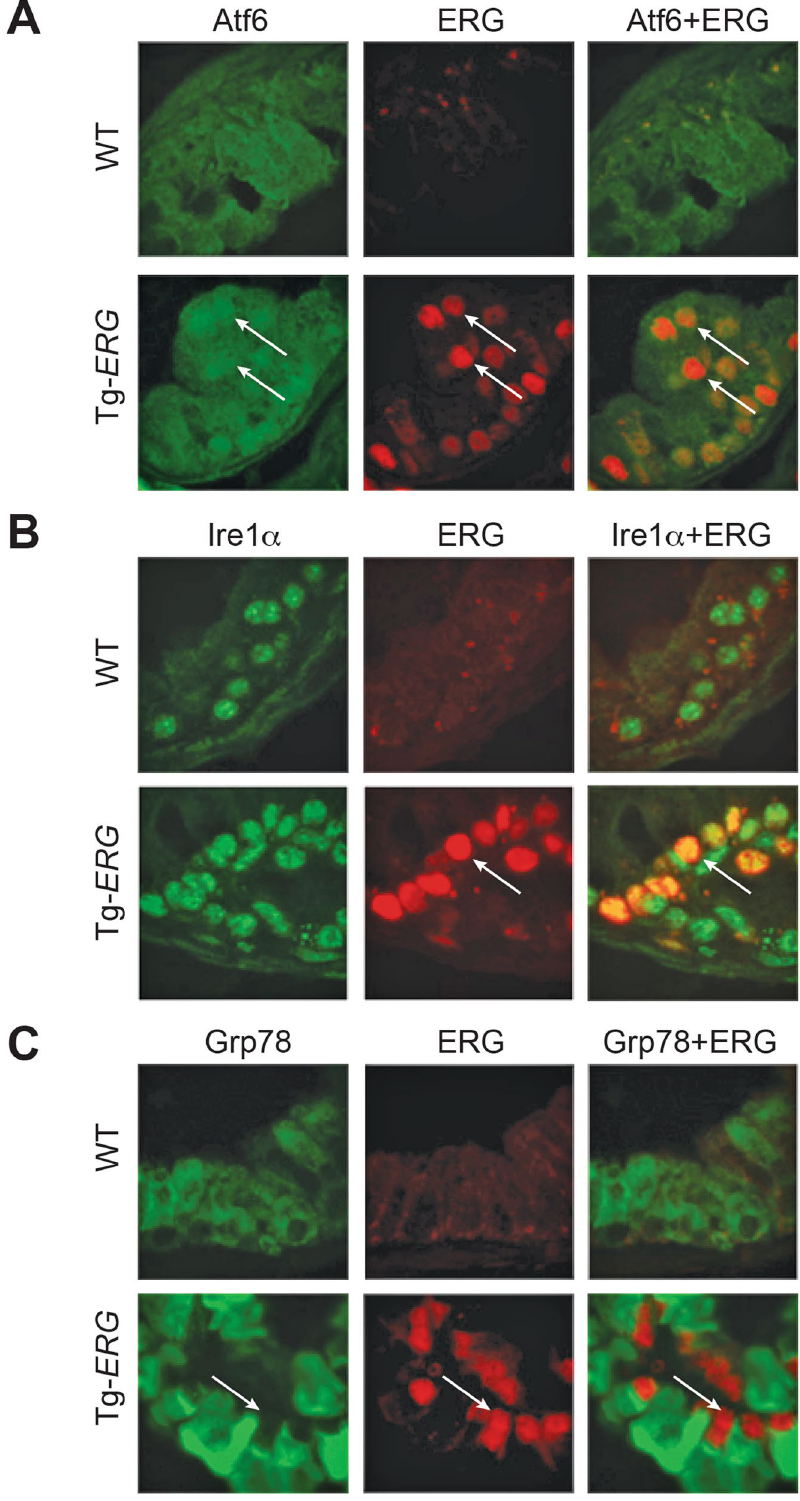
Figure 5. Colocalization of ERG with ER stress sensors Atf6, Ire1 α and ER chaperone protein Grp78/BiP by indirect immunofluorescence in 9 month-old Tg- ERG mouse prostate glands. Immunolocalization of Atf6 reveals the presence of activated Atf6 in the nucleus of Tg- ERG prostate luminal epithelial cells along with colocalized ERG (white arrows in the lower panel of A ). Ire1 α expression was increased in the Tg- ERG mouse prostates, correlating well with the colocalized expression of ERG in the luminal epithelial cells (white arrows in the lower panel of B ). ER resident chaperone protein Grp78/BiP, localized mainly in the cytoplasm of the luminal epithelial cells was increased in Tg- ERG mouse prostates (white arrows in the lower panel of C